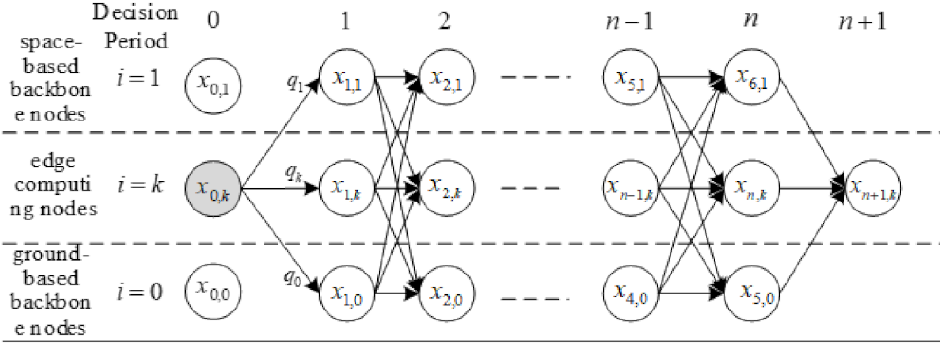
Figure 2. Markov State Transition Model. The Space–Air–Ground Integrated Network is abstracted into an offloading network model represented by Markov states, with i denoting the task offloading location and circles de-noting the Markov states in each decision period. Taking the edge access network in the middle layer as an example, the whole Markovian decision process is given, which is represented by gray